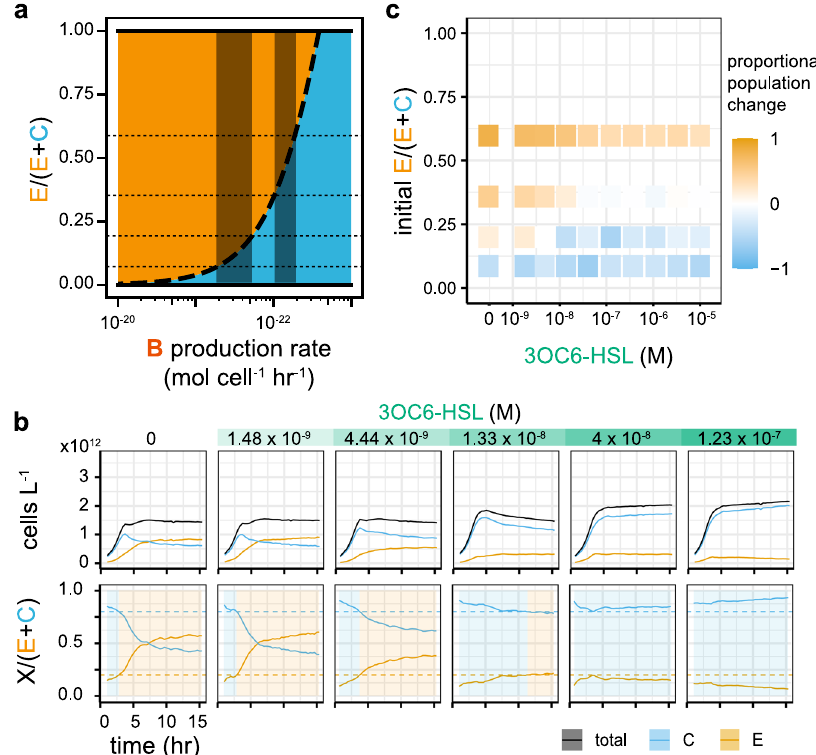
Fig. 5 Exogenous control of competition. a Analysis of the mathematical model with varying bacteriocin expression rate. Note that the x axis is reversed to mimic the direction of 3OC6-HSL control, i.e., high bacteriocin production rate on the left, low bacteriocin production rate on the right. The dotted horizontal lines mark the initial population ratios from c . The shaded regions show the possible regions of maximum and minimum bacteriocin production rate based on c . b Dynamics of co-cultures grown in different concentrations of 3OC6-HSL. c The “ winning ” strain after 5 h of co-culture, with varying 3OC6-HSL concentration, across several initial population ratios. Mapping these results onto a shows the possible regions of minimal and maximal bacteriocin expression rate within which our system is operating. In b , the lines show the rolling mean (centred window size = 3) of one replicate. Further replicate shown in Supplementary Fig. 2. In c , each shaded rectangle shows the proportional population change of one replicate, calculated at 5 h post- inoculation.